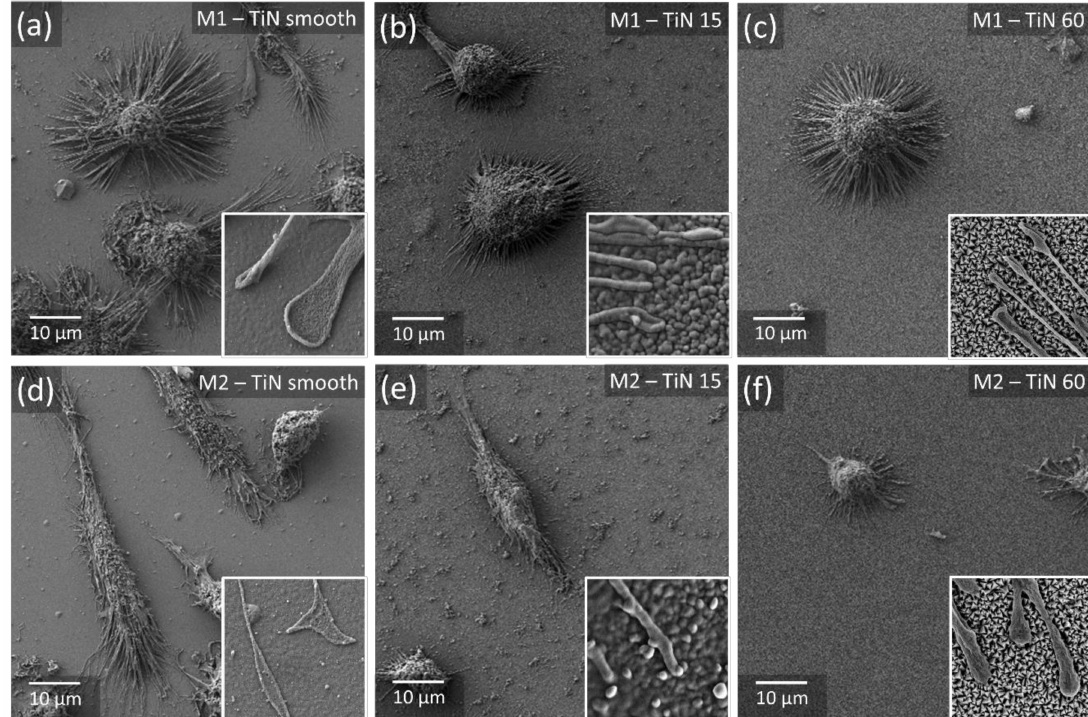
Figure 6. Morphological analysis of biomaterial-resident macrophages. Following 48 h of culture, cell morphology of the two phenotypes ( a – c ) M1 and ( d – f ) M2 was visualized by SEM imaging.